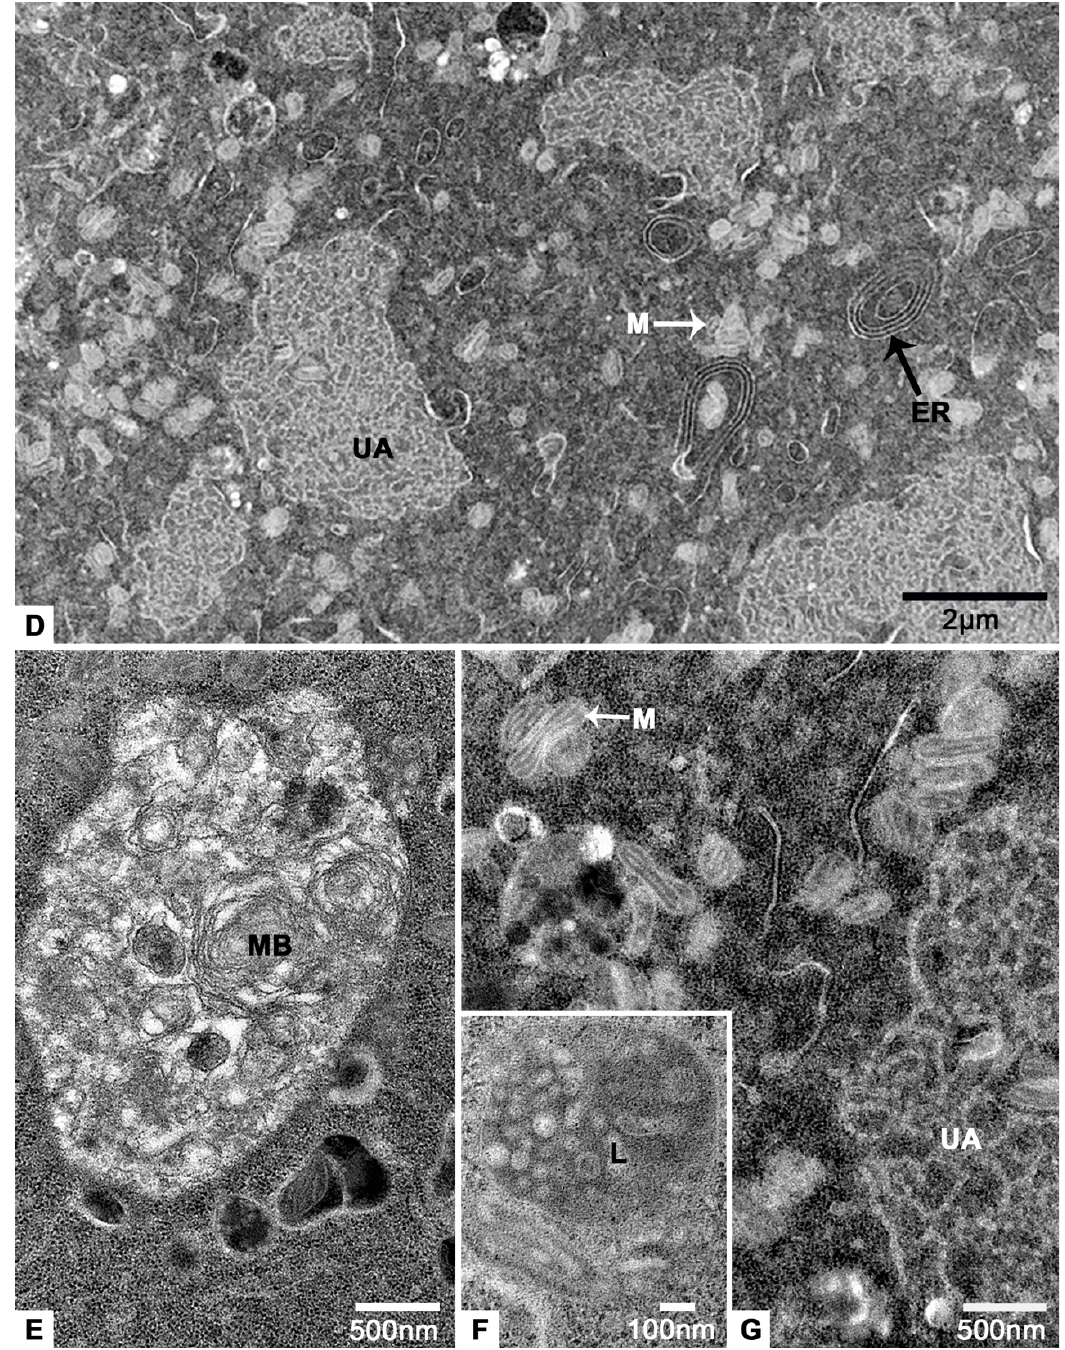
Figure 8. On sixteenth day post-eclosion, the oocyte and follicular cell of T. klimeschi in early vitellogenesis. ( A ) Oocytes become significantly larger. ( B ) Follicular cells become columnar and arranged in a monolayer. ( C ) The microvilli. ( D – G ) The cytoplasmic content of oocyte. Nucleus of an oocyte (ON); nucleoli of an oocyte (ONU); follicular cell (FC); microvilli (MV); mitochondria (M); endoplasmic reticulum (ER); multilamellar body (MB); lysosomes (L); and unidentified aggregates (UA).